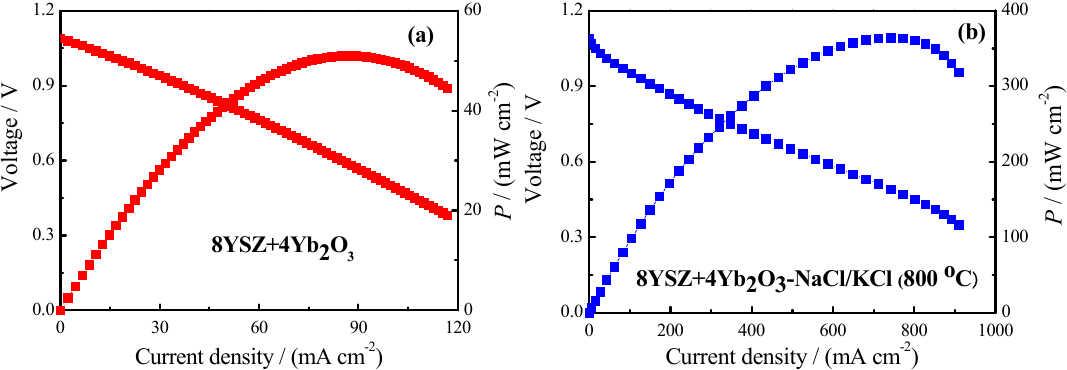
Figure 7. I - V and I - P curves based on 8YSZ+4Yb 2 O 3 and 8YSZ+4Yb 2 O 3 -NaCl/KCl (800 °C) at 700 °C.